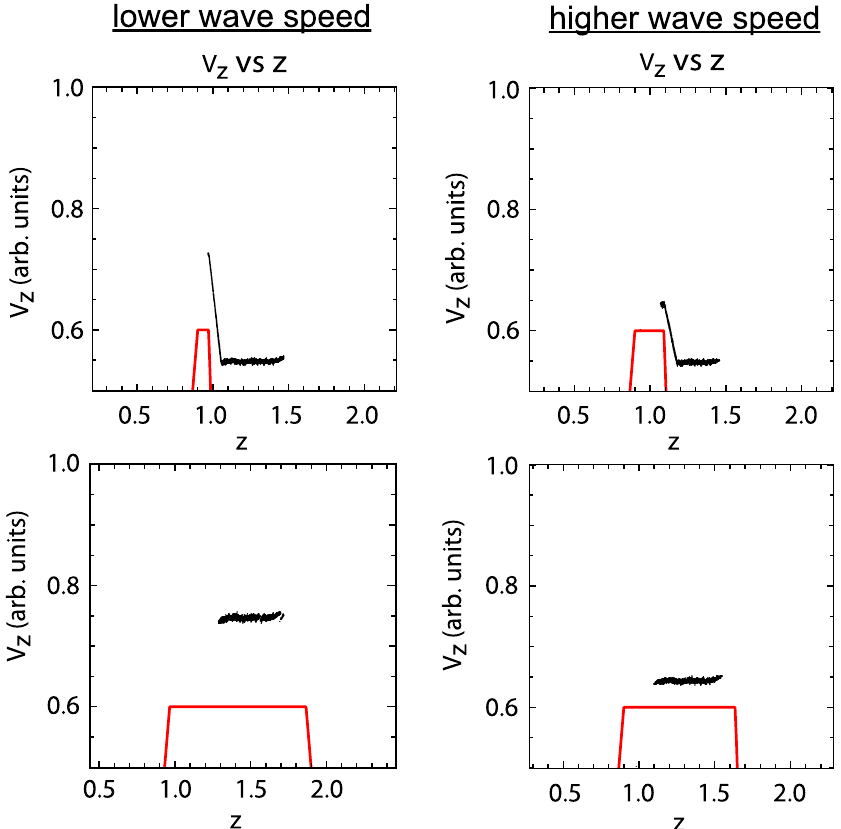
FIG. 4. (Color) Higher wave speed results in lower energy gain of the ion beam. Both helices start at z ¼ 0 : 7 m and end at z ¼ 1 : 9 m .